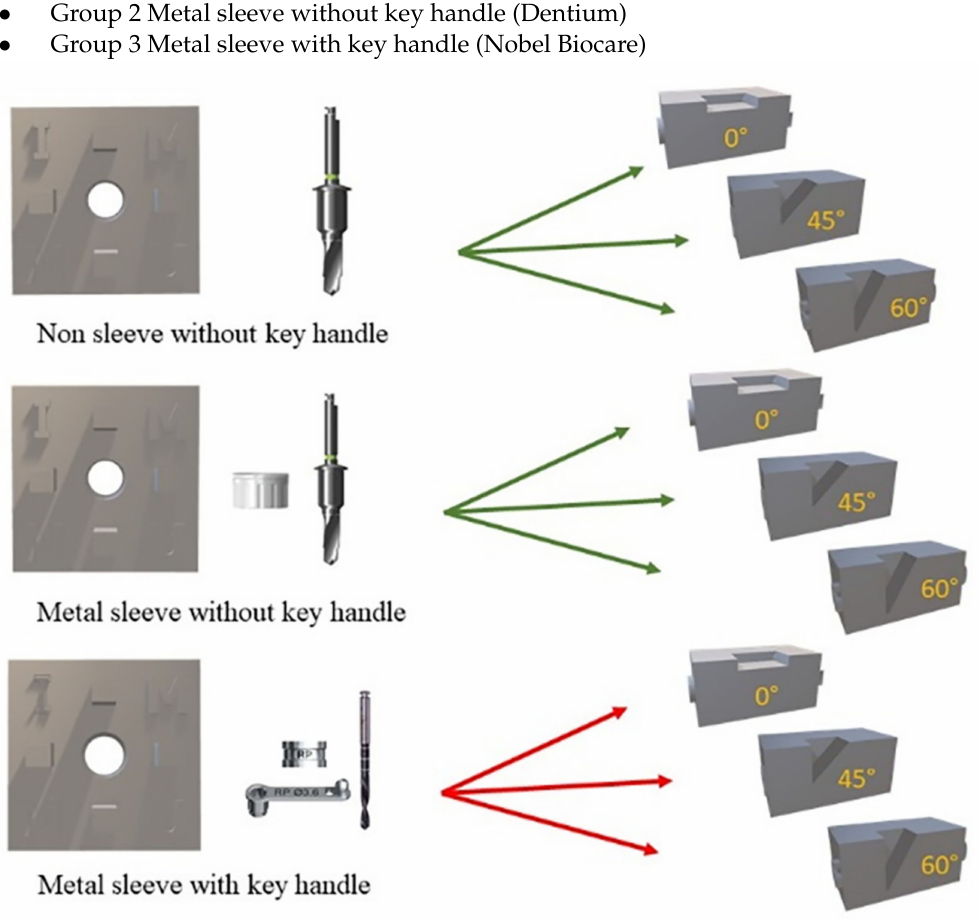
Figure 5. Experimental testing is divided into 3